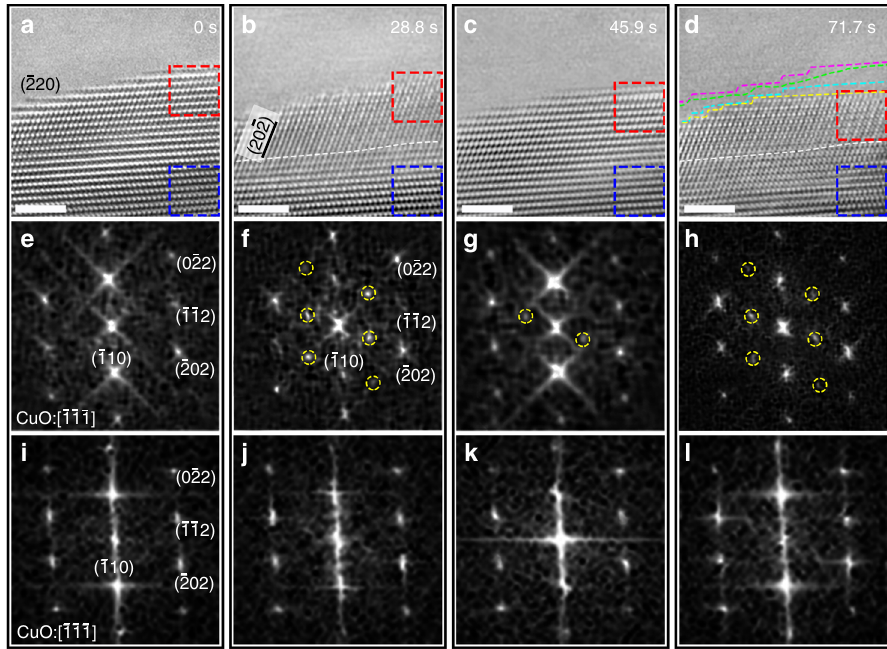
Fig. 1 Atomic-scale visualization of structural oscillations in CuO lattice. a – d Time-resolved HRTEM images (Supplementary Movie 1) of the CuO lattice upon exposure to a continuous fl ow of hydrogen gas at T ≈ 300 °C and pH 2 ≈ 0.5 Pa. The pink, green, arctic, and yellow dashed lines in d are the traces of the position and con fi guration of the outer surface at 0 s, 28.9 s, 45.9 s, and 71.7 s, respectively, showing the oxide decay via the retraction motion of atomic steps at the outer surface. The white dashed lines in b , d mark roughly the boundary between the superlattice region and the deeper unaffected region. e – h Diffractograms from the subsurface region as marked with the red dashed box in the HRTEM images, showing the reoccurrence of superlattice diffraction spots indicated by yellow dashed circles. i – l Diffractograms from the deep region as indicated by blue dashed box in the HRTEM images, indicating that the deeper regions of the CuO lattice stays unaffected during the entire process. Scale bar, 2 nm ( a – d